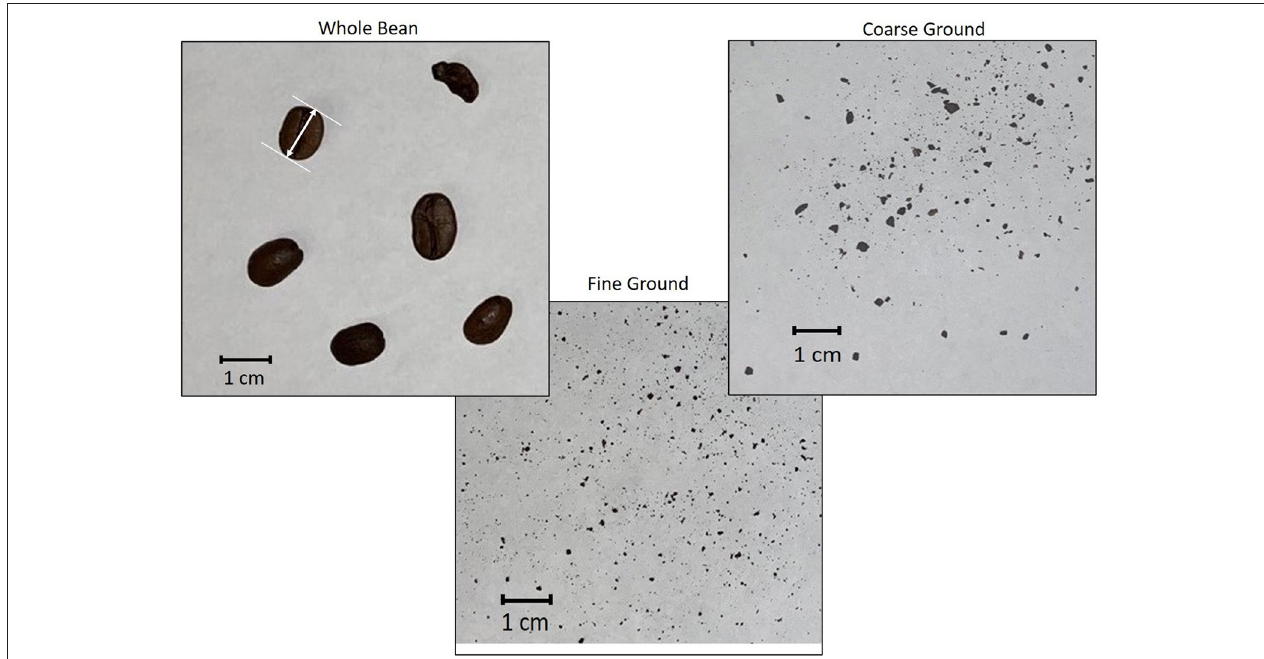
Freshly roasted coffee Stored coffee Roast